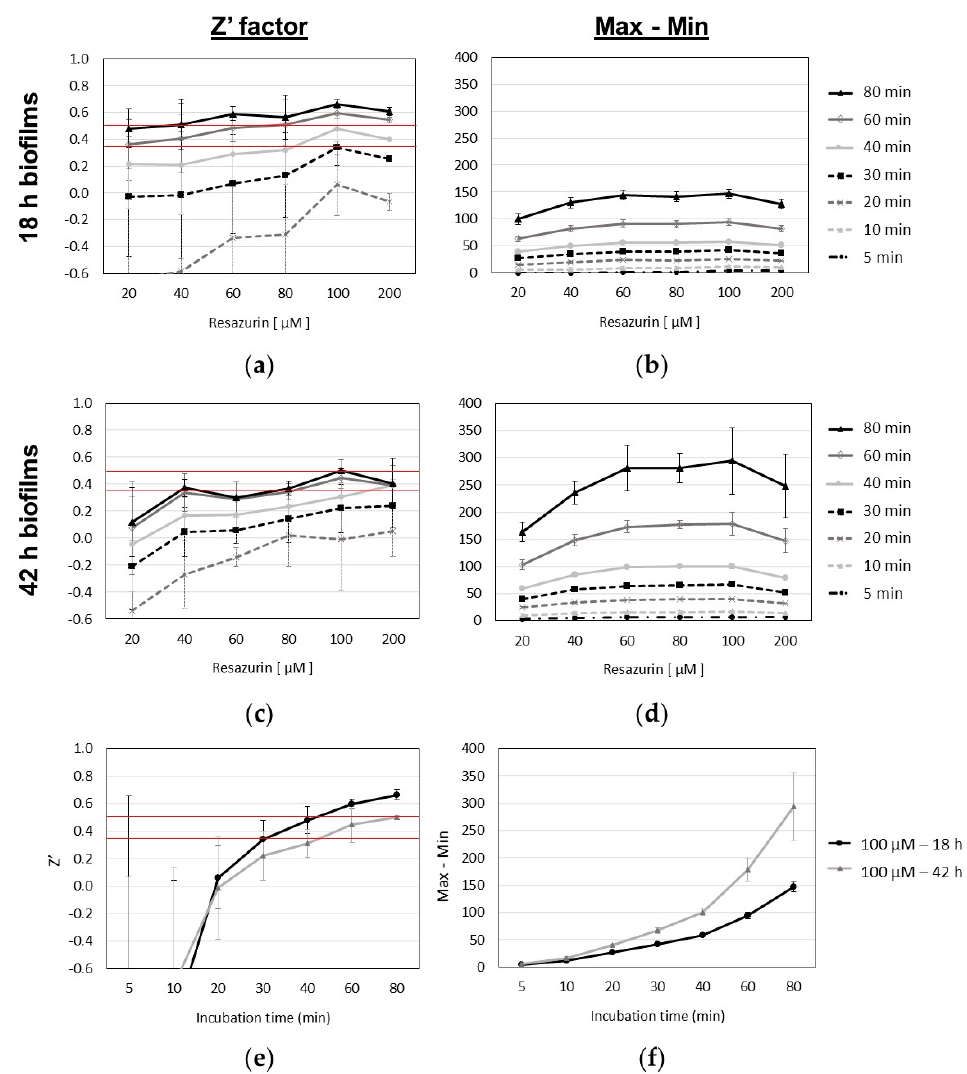
Figure 4. Effect of different resazurin concentrations and incubation times with the dye on the performance of a miniaturized biofilm screening assay in 384WP with P. aeruginosa . Assay performance is measured using Z’ factor ( a , c ) and maximum minus minimum signal ( b , d ) of the resazurin staining of P. aeruginosa biofilms grown for 18 h or 42 h in a volume of 40 µL with a concentration of the bacterial inoculum of 1.75 × 10 5 CFU mL − 1 . ( e , f ) show the Z’ factor and the maximum minus minimum signal obtained with the best resazurin concentration over time. Maximum minus minimum results are expressed in RFUs. Results are based on 2 independent biological replica experiments performed at 37 °C, each plate containing from 36 to 48 technical replicates and 12 media control replicates for each condition. The red lines in panels a, c, and e represent the thresholds for determination of the quality of the assay: acceptable (Z’ = 0.35) and good (Z’ = 5).